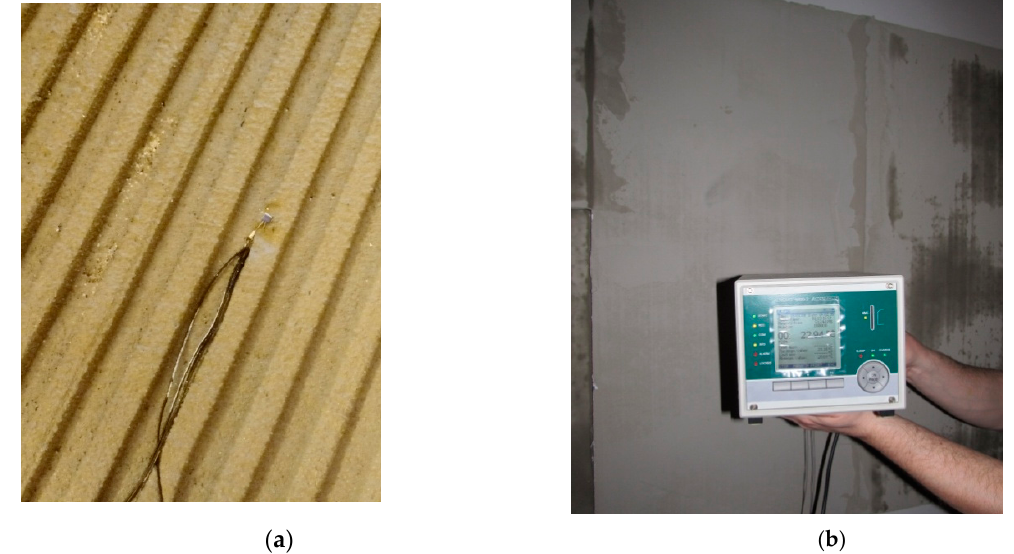
Figure 6. The fragment of the test stand illustrating the installation of boards. ( a ) Sensor type Pt-100; ( b ) installation of the recorder at the test stand.